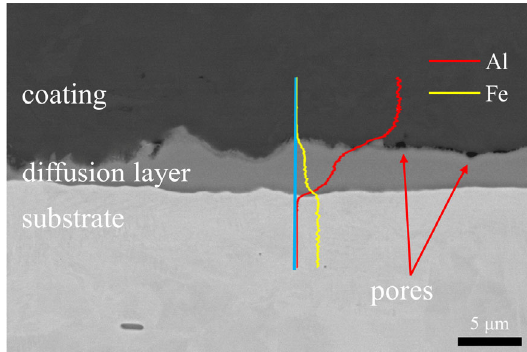
Figure 9. Di ff usion layer after heat treatment at 500 °C. Figure 9. Diffusion layer after heat treatment at 500 ◦